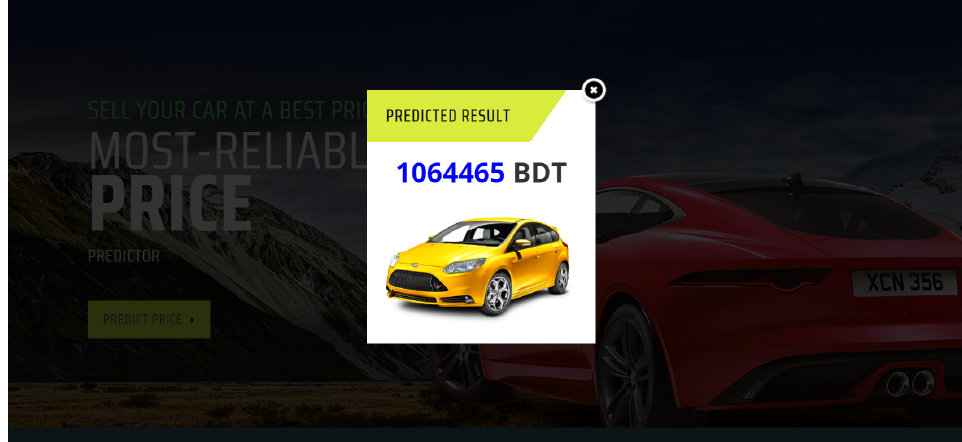
Figure 24. Predicted